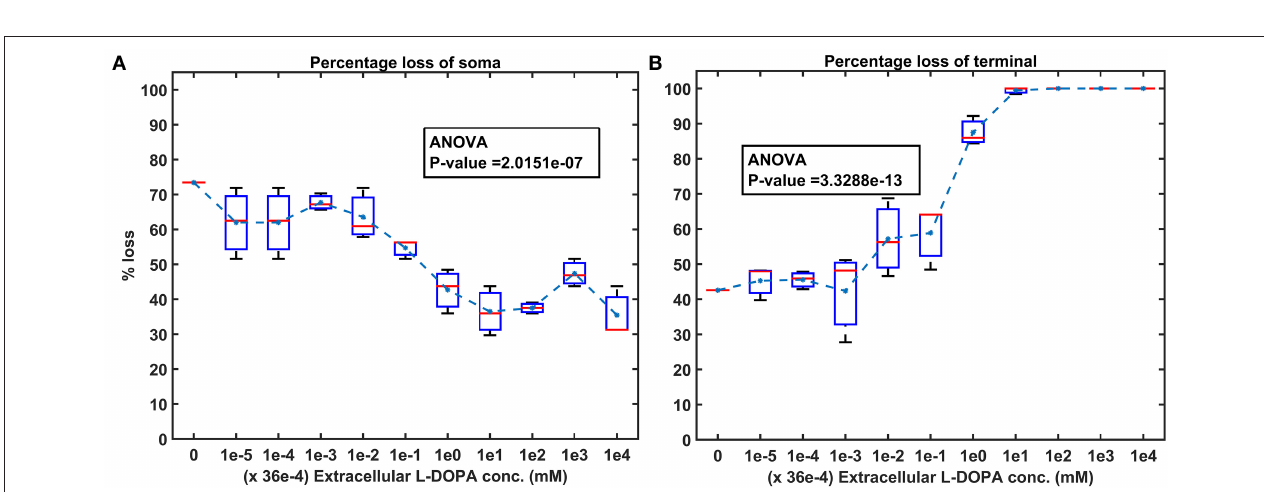
FIGURE 7 | Model response to different extracellular L-DOPA under energy deficiency. (A) Percentage loss of somas for various extracellular L-DOPA concentrations, (B) percentage loss of terminals for various extracellular L-DOPA concentrations. conc, concentration; L-DOPA, levodopa; mM, millimolar.